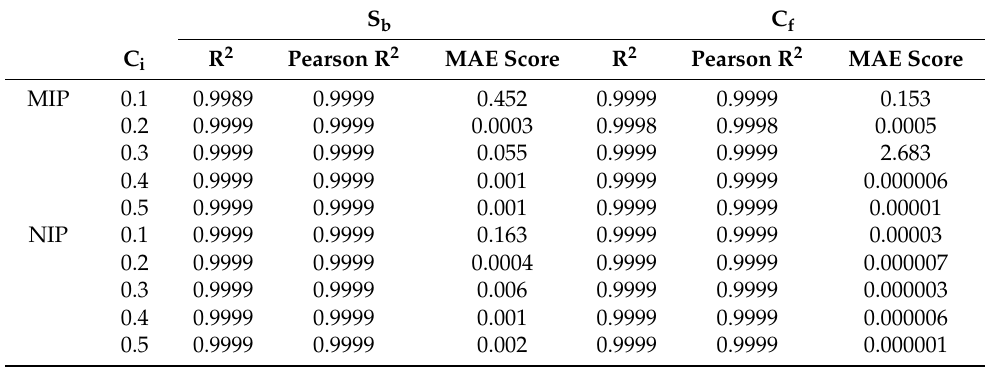
Table 1. Analysis of the error and correlation of the trained datasets at a given C i value.